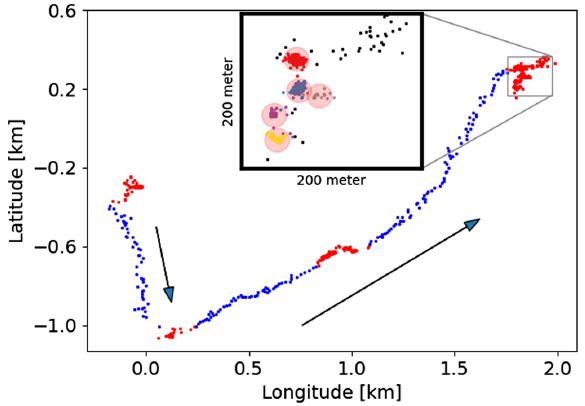
FIG. 1. Foraging tracks are composed of superdiffusive com- muting flights and subdiffusive local search. (a) Seventy-five minutes of tracking at 0.5 Hz (2280 localizations) of a randomly selected female owl (tag 4782), segmented into four ARS (red) of 4, 2, 4, and 56 min long, and three commuting segments (blue), each lasting approximately 1 min. The arrows show the direction of motion. The inset shows local search within a single ARS (size 200 × 200 m 2 , 56 min long), with five local clusters (WTs of 14, 36, 2, 3, and 1 min), each represented by a different color and highlighted by a red circle. The owl performs local jumps of 25 to 45 m between the local